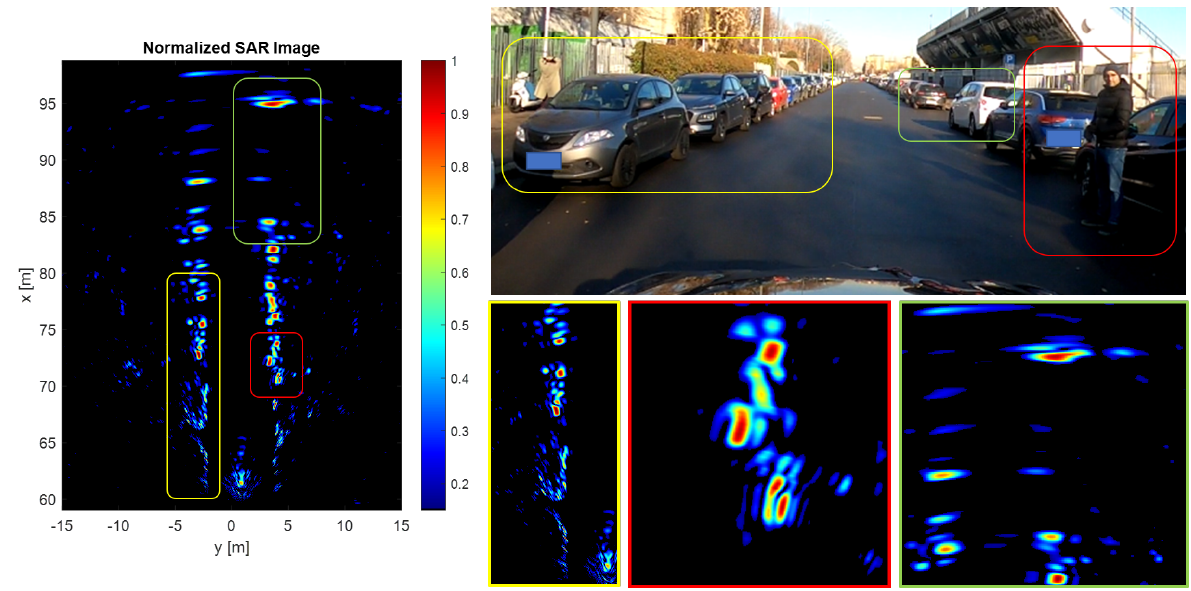
Figure 15. ( left ) SAR image of the field of view: ( top right ) Optical image. ( bottom right ) Three de- tails of the SAR image highlighted with the some color in the optical image and in the full-field SAR